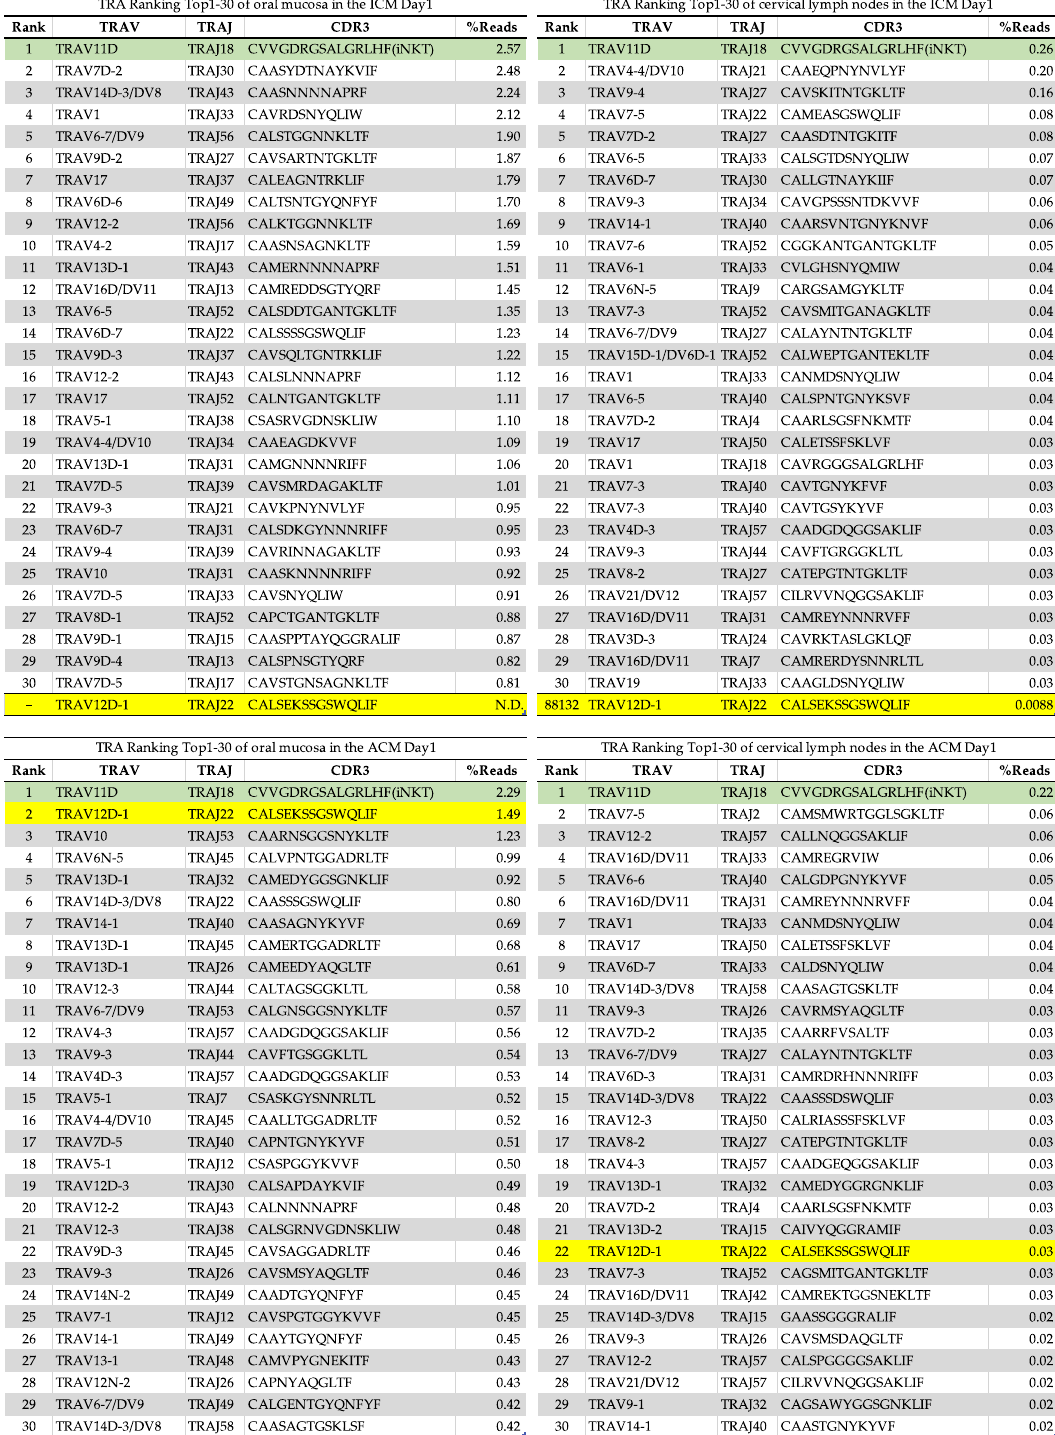
Figure 6. Ranking of the top 30 most frequently read TRA clonotypes (as a percentage) in the oral mucosa and cervical lymph nodes of the ICM and ACM mice at Day 1 post ‐ challenge. Distributions of frequency (%) reads of amino acid sequences of CDR3 regions in the oral mucosa and cervical lymph nodes of the ACM mice revealed the presence of Cr ‐ specific T ‐ cells bearing TRAV12D ‐ 1 ‐ TRAJ22 (yellow shading). In both the oral mucosa and the cervical lymph nodes of the ICM and ACM mice, iNKT ‐ cells (green shading) are highly expressed. N.D. = not detected.